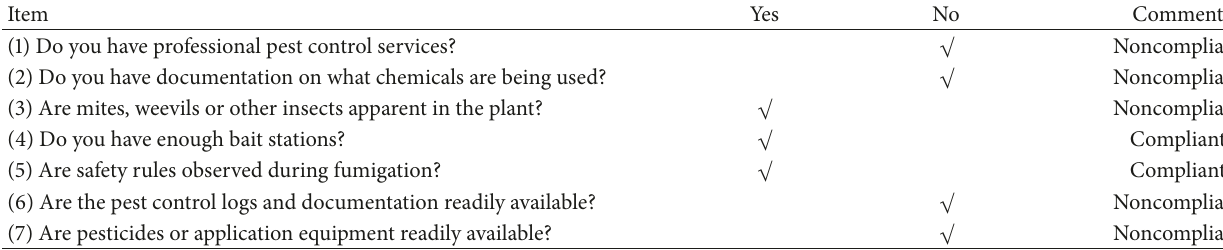
Table 5: Assessment of GMPs on pest control programs for OFSP puree